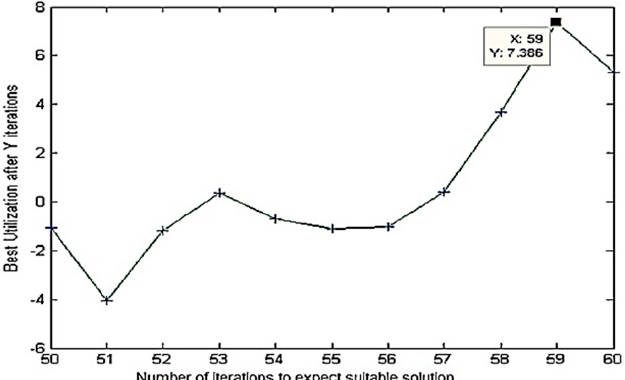
Figure 11. The iterations to get scheduling by proposed